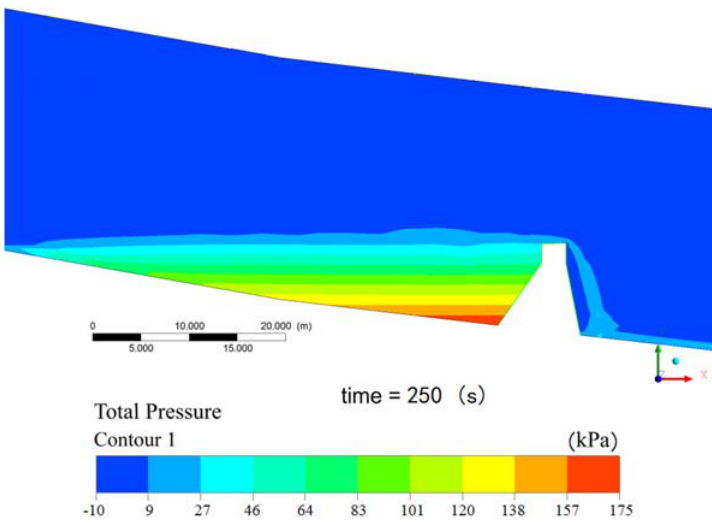
Figure 12. Total pressure with the height of the barrier.